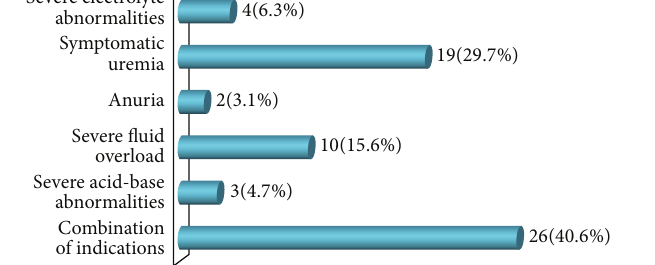
Figure 2: Indication for RRT in patients who required it.